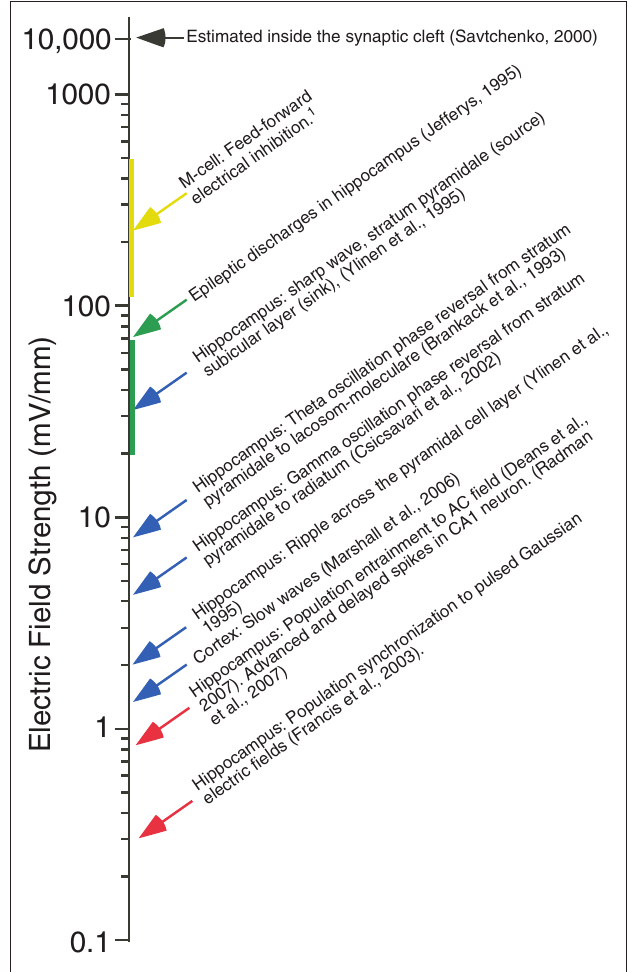
Figure 4 | A comparison of the strength of endogenous electric fields with that of exogenous fields shown to alter spike timing in vitro . Approximate strength of endogenous electrical fields resulting from normal activity in the cortex and hippocampus (blue arrows), as well as the in the M-cell system (yellow arrow, vertical line indicates range). The approximate field strength of epileptic discharges (green arrow and vertical line). Spike timing in hippocampal slices (red arrows) is altered by exogenous fields that are considerably weaker in